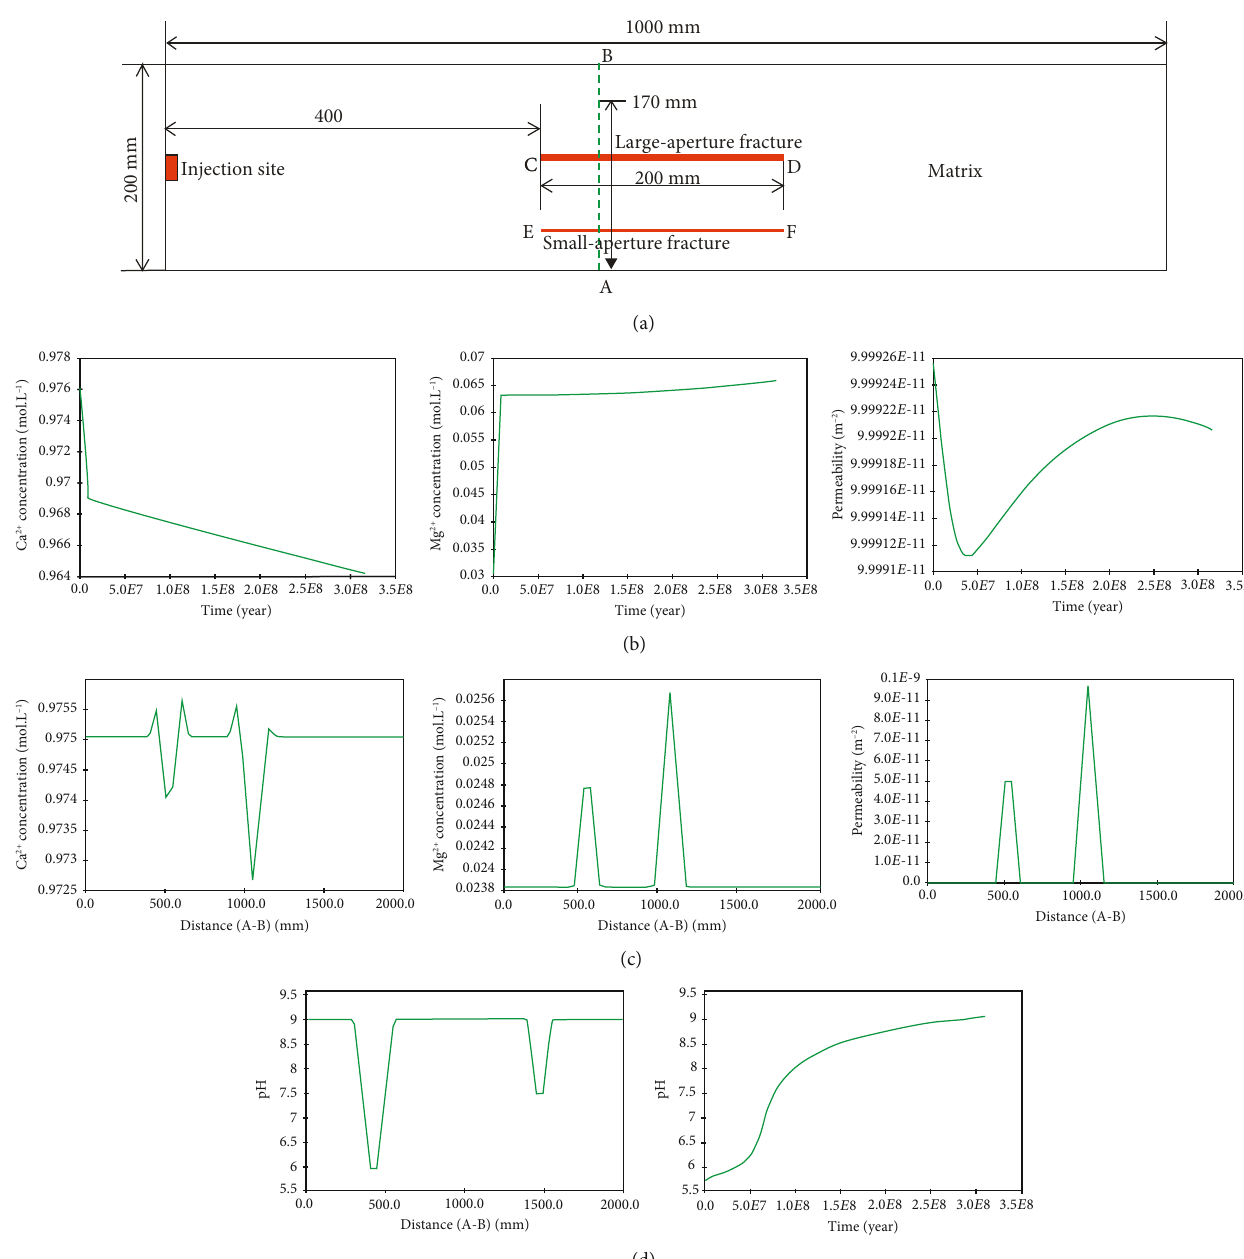
Figure 6: Distribution of ion concentration, mineral abundance, and permeability obtained from six di ff erent simulations along section A-B. (a) Top view of 3-D model; (b) ion concentration and permeability change in points of fractures over time (C-D and E-F); (c) contrast of ion concentration and permeability changes between fractures after 100 years; (d) pH value of solution changes along section A-B over